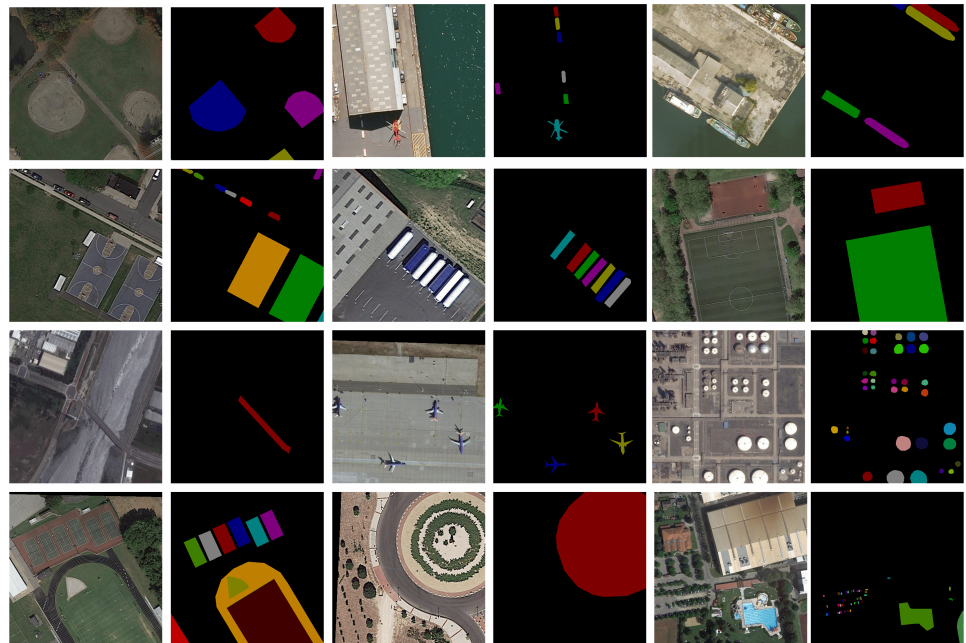
Figure 5. Illustration of the iSAID-Reduce100 dataset. There may be different objects in an image.